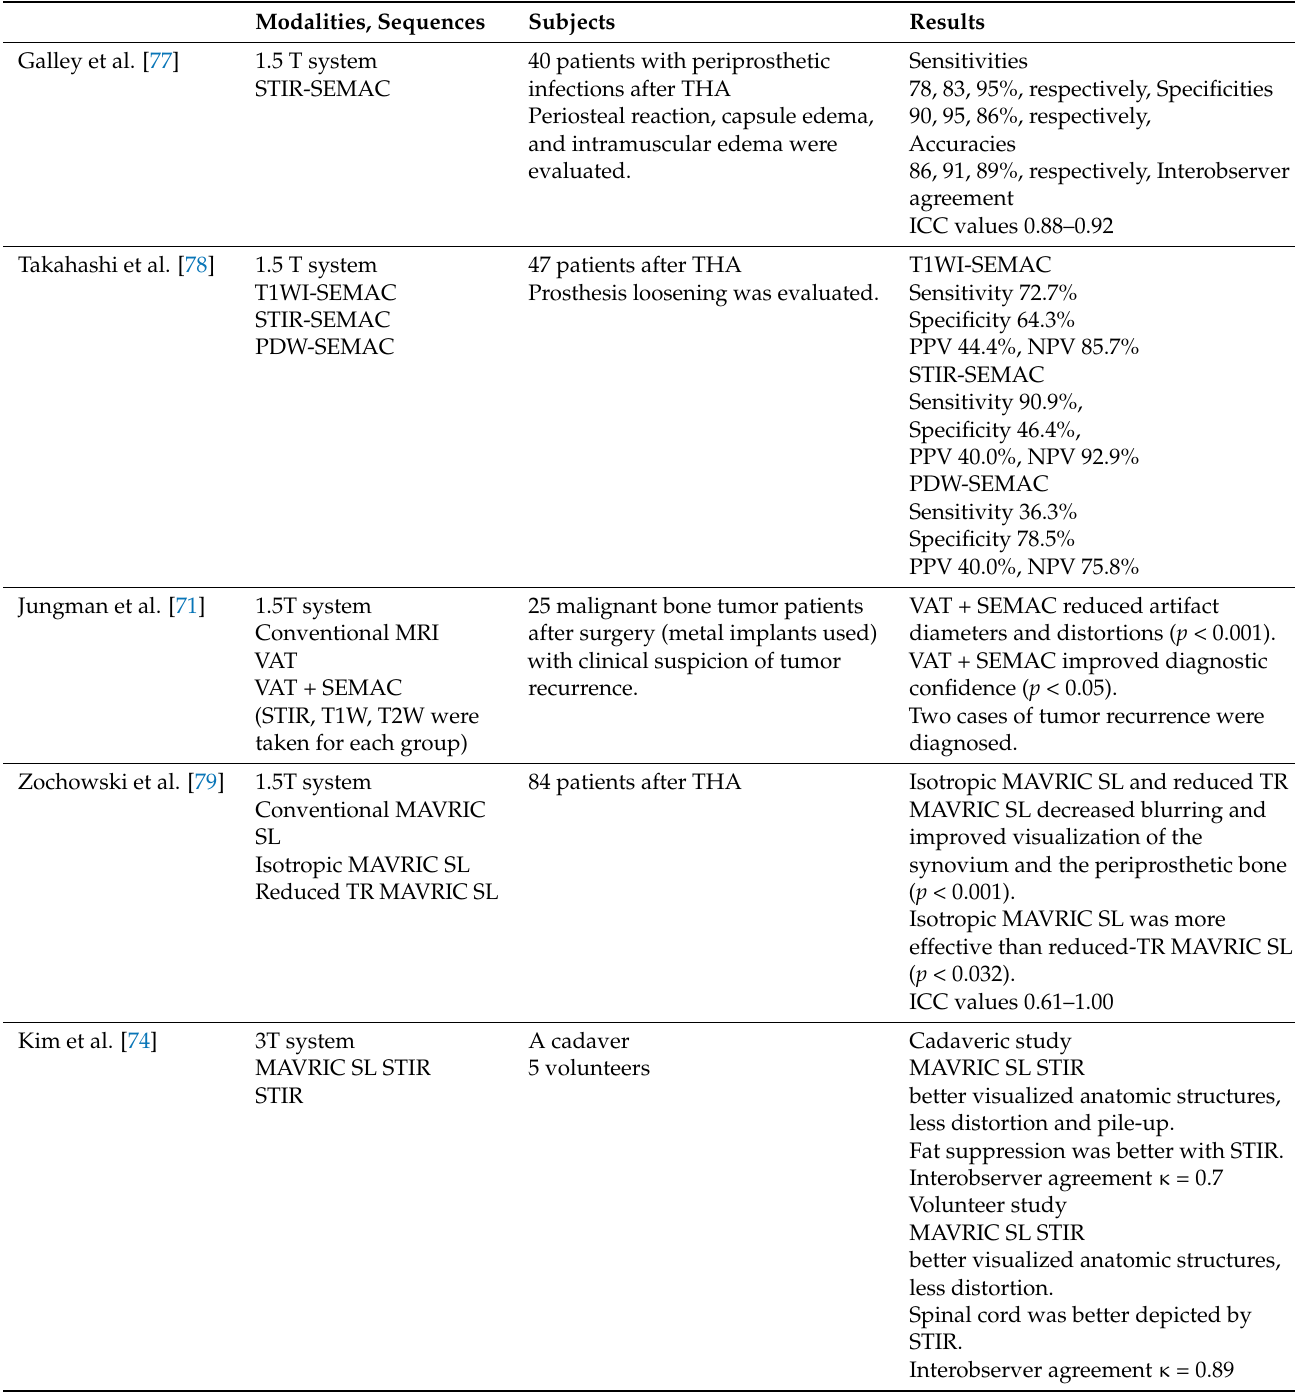
Table 3. Overview of representative MRI studies. Major results are presented. AUC value was not mentioned unless described. Magnetic resonance imaging: MRI ; short inversion